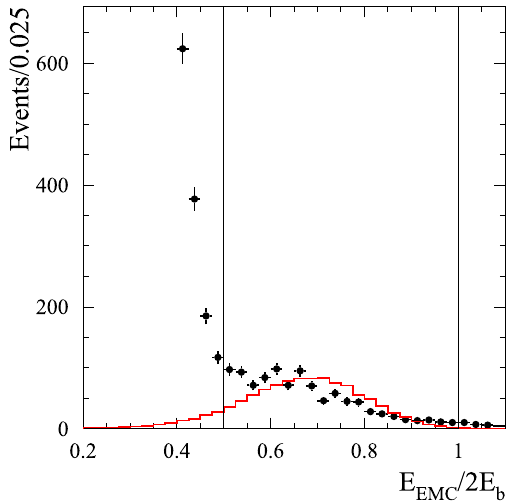
Fig. 2 The distribution of the normalized total EMC energy deposi- tion E EMC / 2 E b for 2019 data events with E b = 945, 950, 951 MeV (points with error bars) Events are satisfied the standard selection cri- teria except for the condition on E EMC . The histogram represents the same distribution for simulated signal events. The vertical lines indicate the boundaries of the condition E b < E EMC < 2 GeV